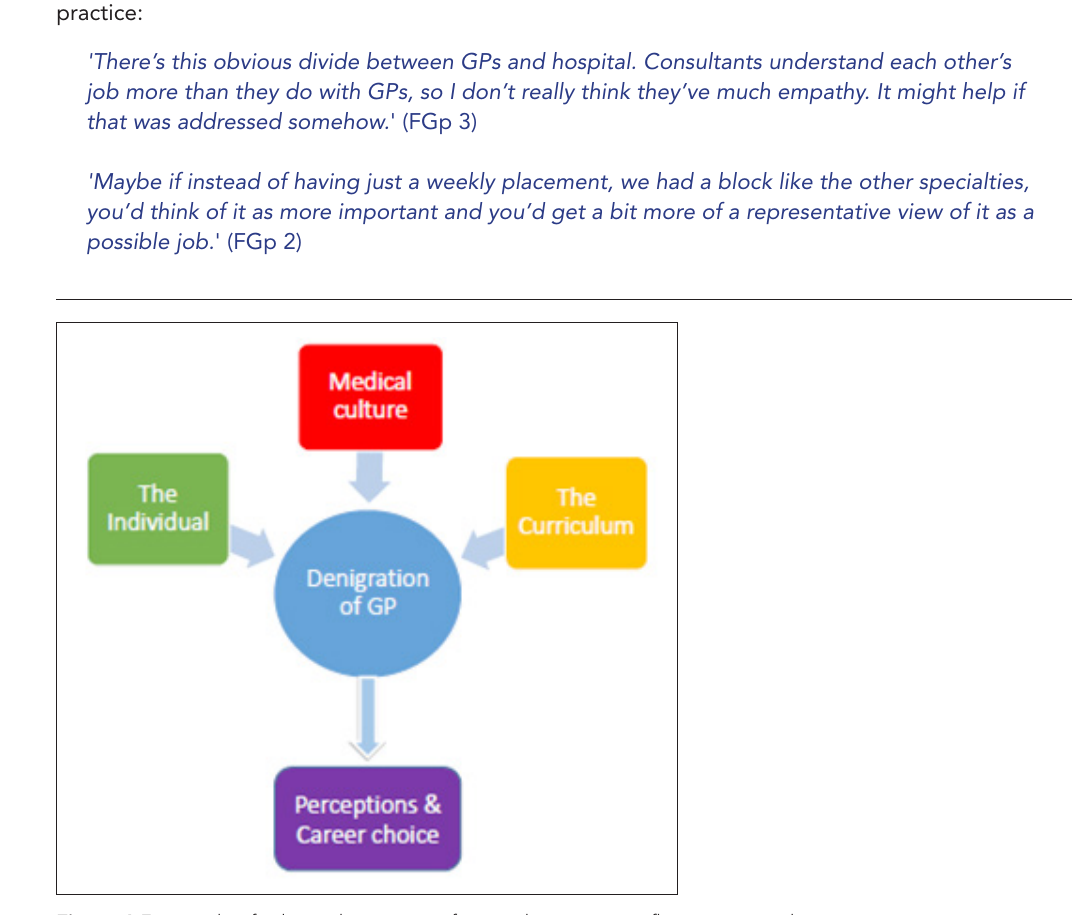
Figure 1 Factors that facilitate denigration of general practice to influence career